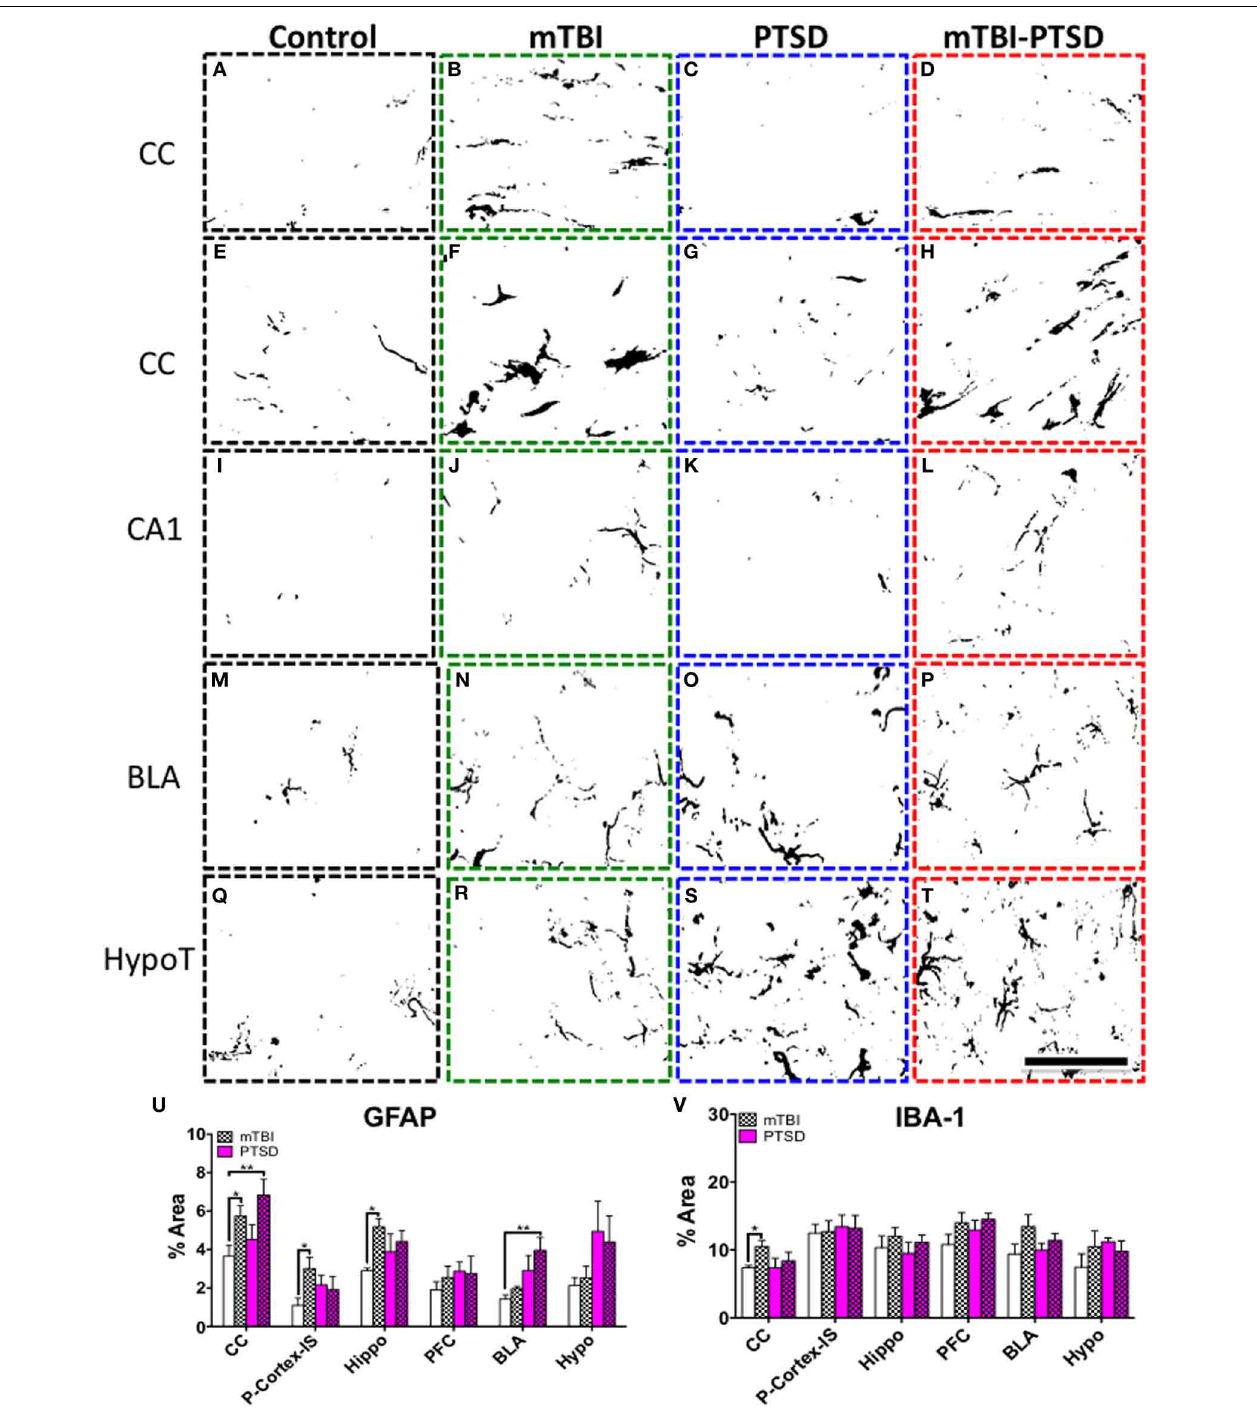
FIGURE 9 | Neuroglial response in the corpus callosum (CC), hippocampus (CA1), basolateral amygdala (BLA) and hypothalamus (HypoT), Parietal cortex- Injury site (P-Cortex-IS). (A–D) depicts microglia IBA + immunoreactivity in the corpus callosum (CC). There was a significant increase in mTBI animals compared to controls ( P = 0.010); this was confirmed by quantitative densitometry (optical segmentation) (V) . (E–T) shows astrocyte GFAP + immunoreactivity in the aforementioned brain regions. There was a significant increase in astroglial activation in the